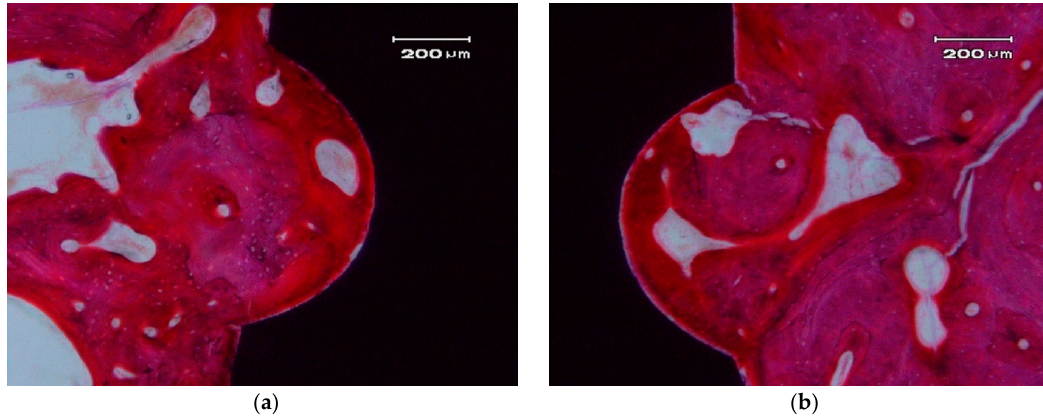
Figure 6. Bone apposition on the surface of a ZCe-A implant after eight weeks of healing (longitudinal cross-section). The bone in contact with the implant shows a lamellar and Haversian structure. ( a ) left side and ( b ) right side of the implant In the hard tissue area, a direct and close apposition of the bone matrix to the implant surface is observed, without the presence of a non-mineralized connective tissue interface.